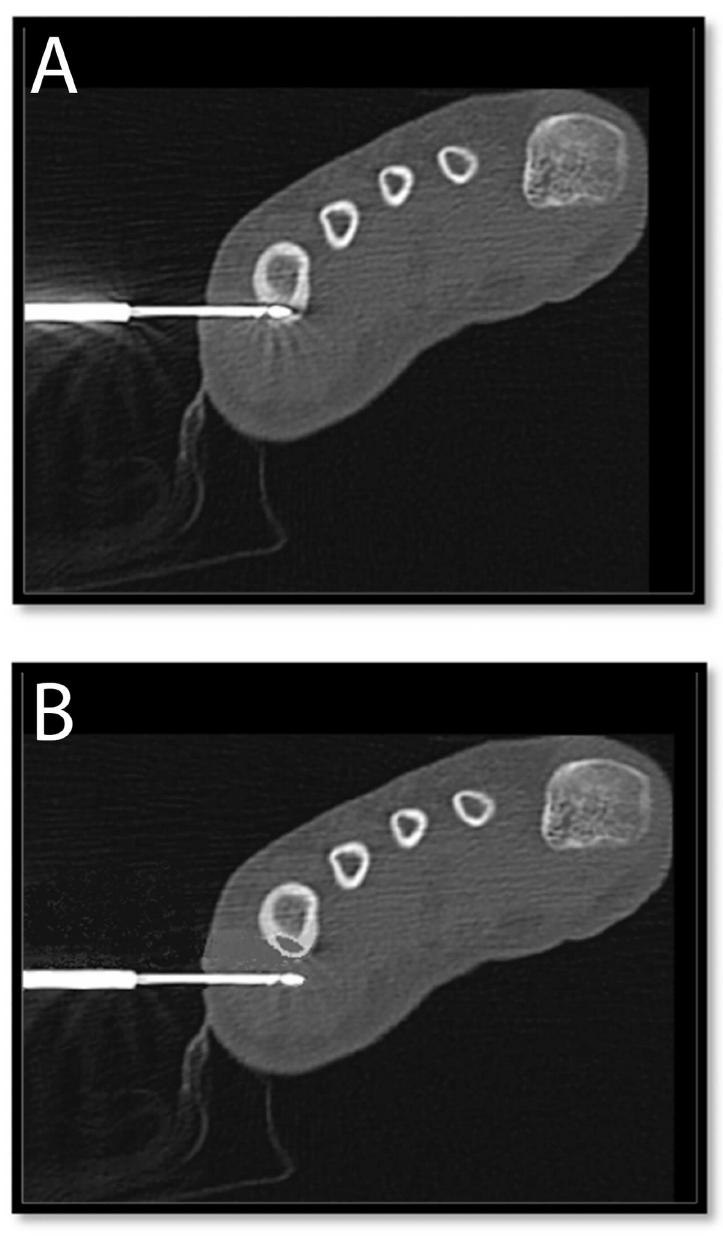
Fig 3. CT images of an ablation needle in situ. Osteoid osteoma in 5th metatarsal. A: Needlein nidus (accurate placement). B: Needleoutside nidus (= inaccurateplacement).